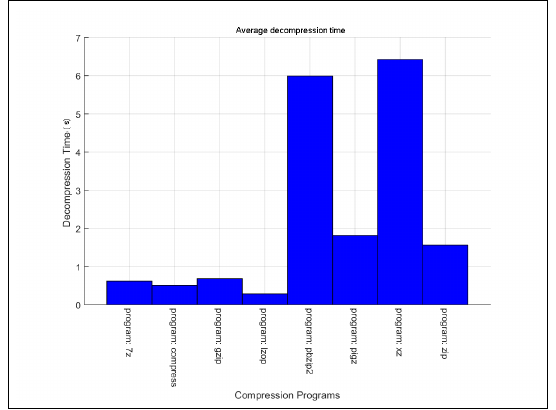
Figure 8: Average decompression time among applied methods.